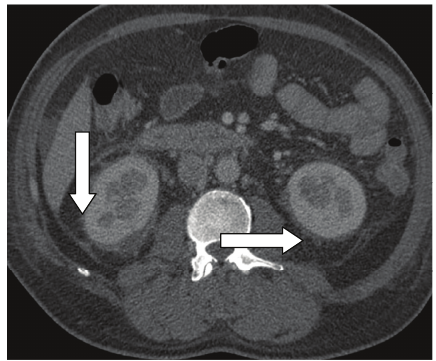
Figure 3: Perinephric stranding.